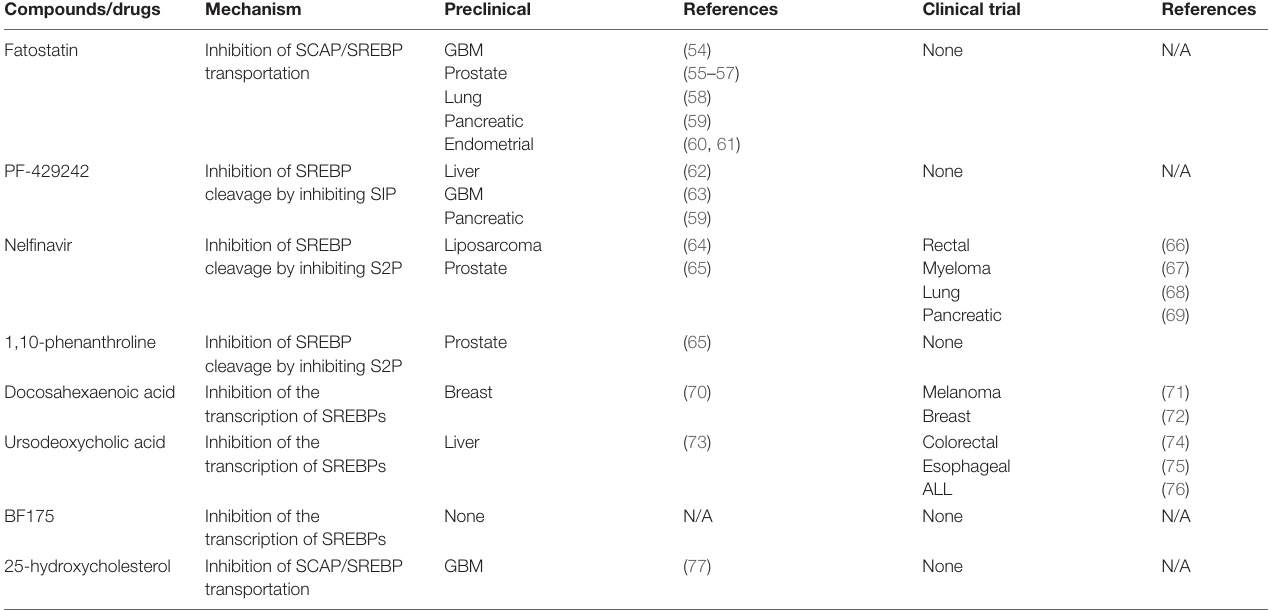
TABLE 1 | The classical inhibitors targeting SCAP/SREBPs in cancer cells.